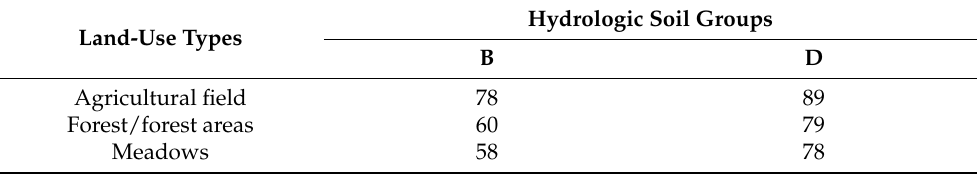
Table 1. CN look-up